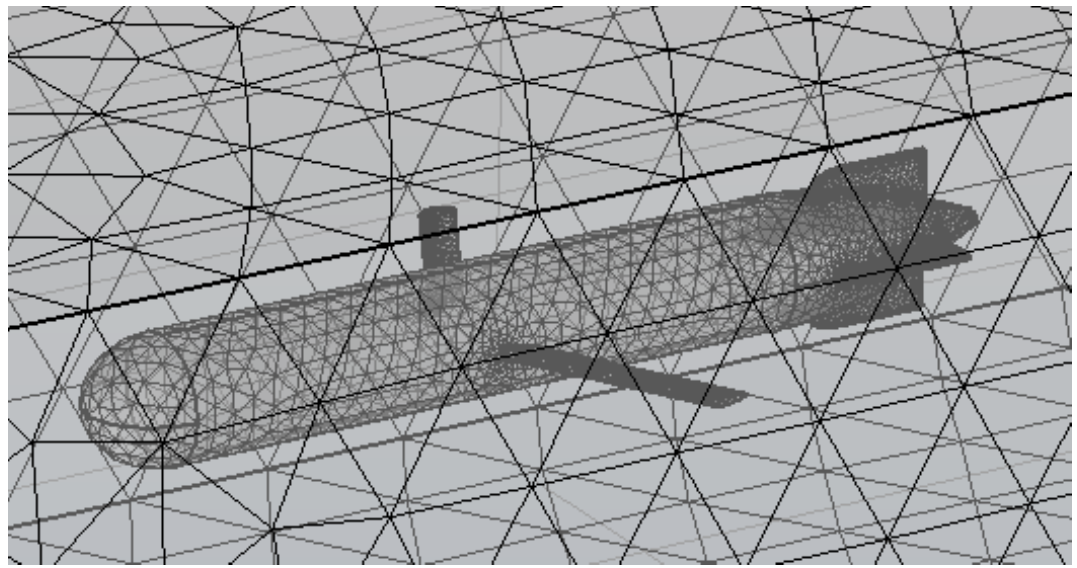
Figure 3. The dense mesh around the torpedo surface used for computation.